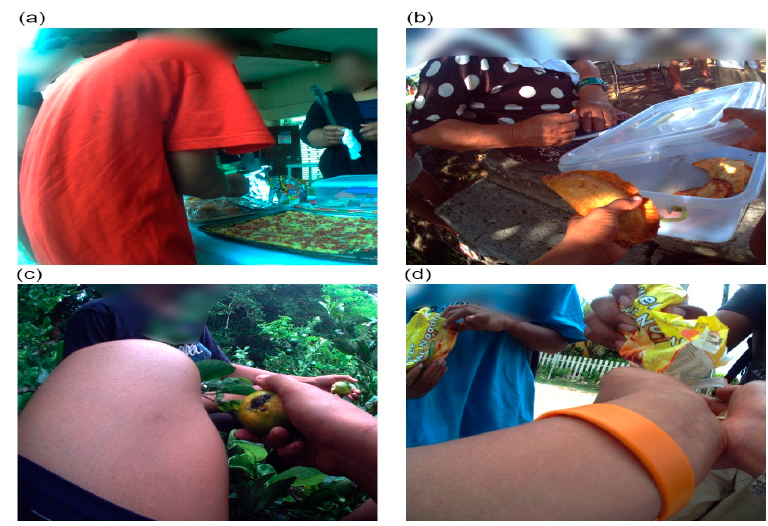
Figure 4. Food source ( a ) market, ( b ) school stall, ( c ) ngoue’anga (garden), and ( d ) other child.